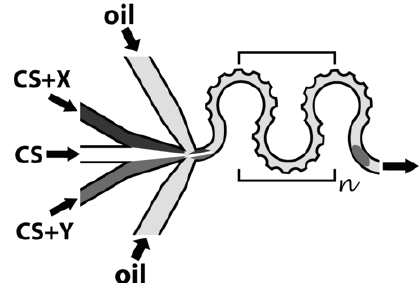
Figure 26. A meandering channel with bumps on the outer side for use in mixing three kinds of liquids (from Liau et al.